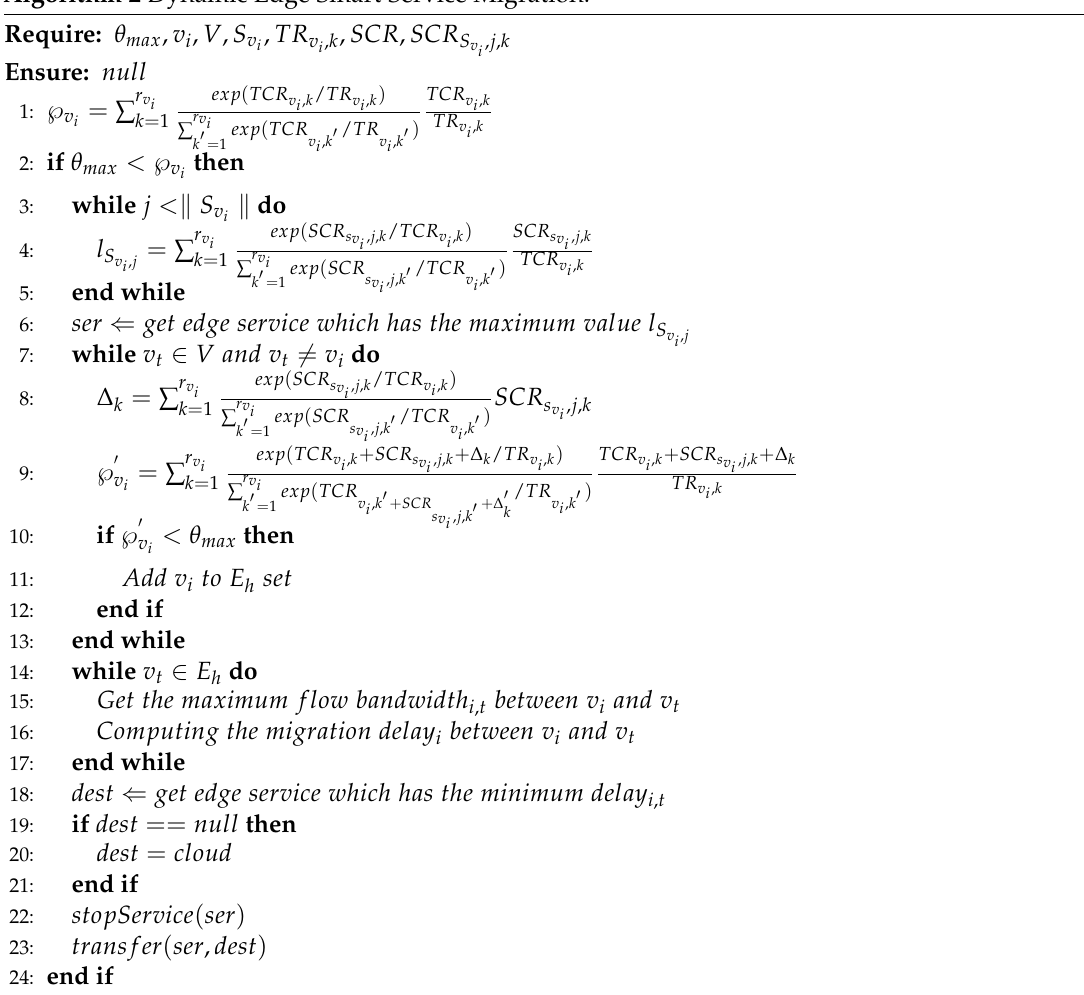
Algorithm 2 Dynamic Edge Smart Service